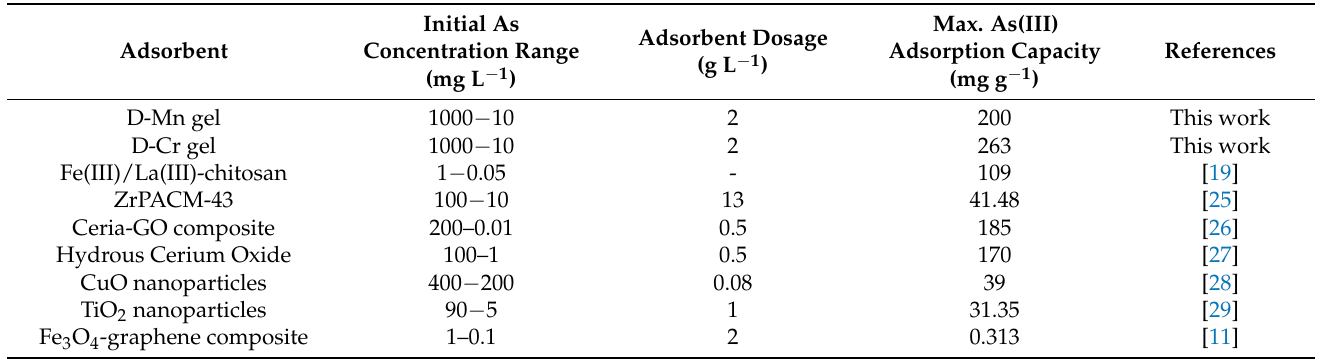
Table 3. Comparison of the maximum As(III) removal capacity of related